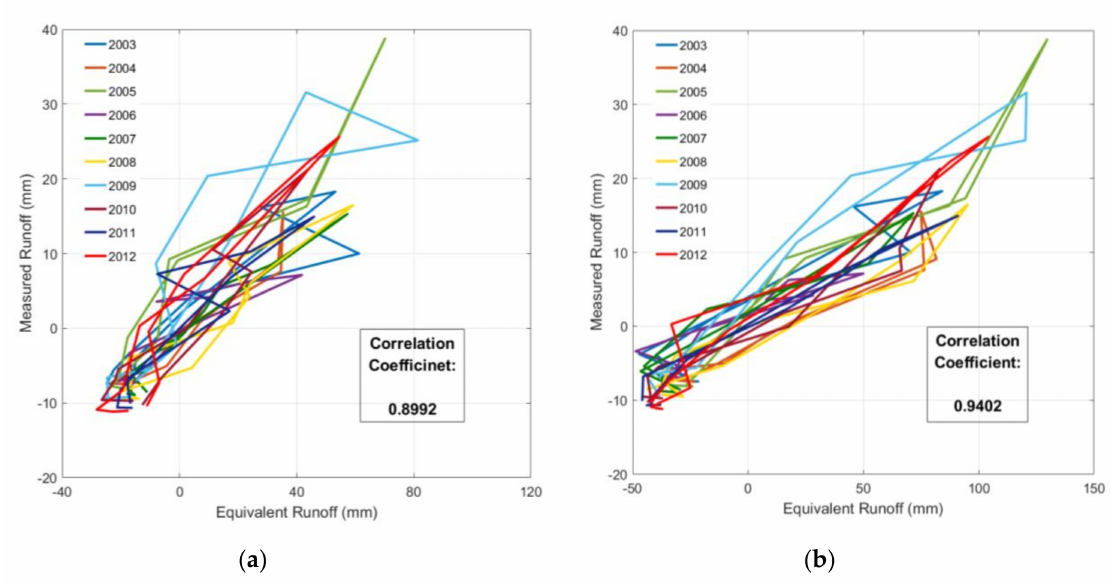
Figure 6. The runo ff versus equivalent runo ff (both after removing the time lag and detrending) plot of YRSR using ( a ) GLDAS-Noah model, and ( b ) CNMIC gauging station; ( a ) YRSR (detrending) R-Reqv (GLDAS) plot; ( b ) YRSR (detrending) R-Reqv (CNMIC)